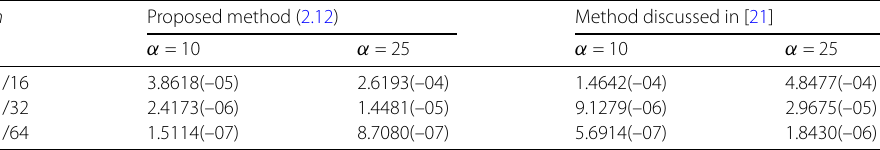
Table 7 Problem 8.7: The maximum absolute errors h Proposed method